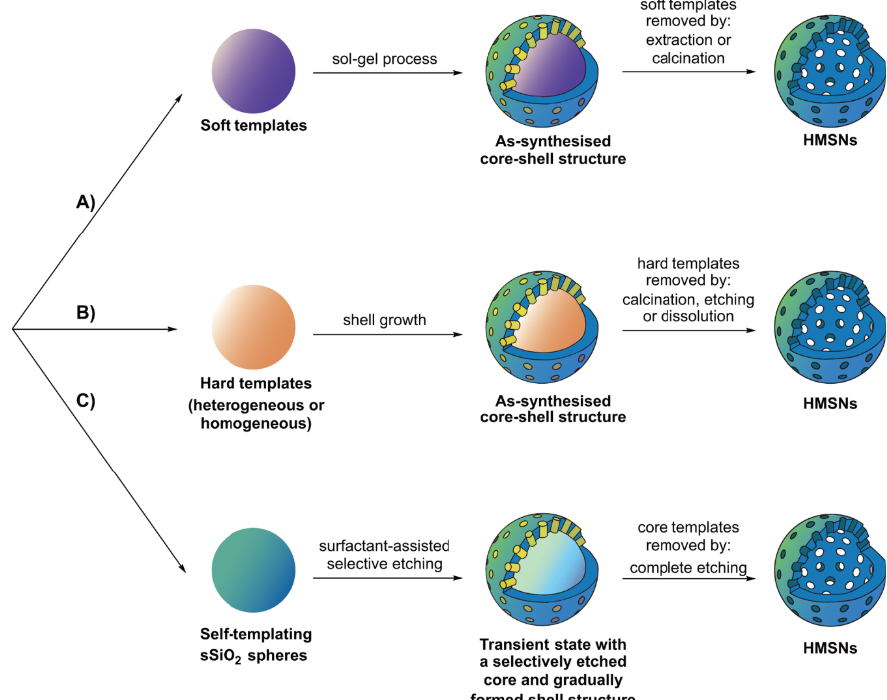
Figure 2. A schematic detailing the three synthetic routes for fabrication of hollow mesoporous silica nanoparticles (HMSNs), namely “soft-templating”, “hard-templating” and “self-templating”. All three routes start from the formation of the core template. Route ( A ) is a two-step process, resulting in the formation of HMSNs after the removal of both the mesopore and core templates. Route ( B ) illustrates the formation of HMSNs by a hard-templating method after the removal of both the mesopore and core templates. Route ( C ) shows the process of self-templating fabrication of HMSNs. The final hollow mesoporous silica nanoparticles are obtained by a complete etching of self-templating solid silica spheres (sSiO 2 ). Common etching agents include strong acids such as HCl and HF, an alkaline medium such as ammonia and NaOH, NaBH 4 or hot water